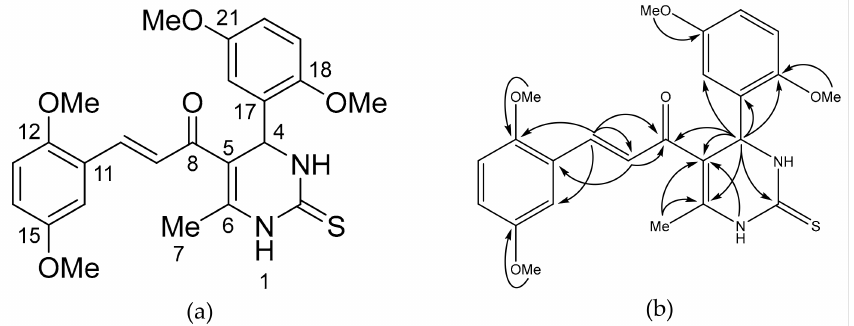
Figure 3. ( a ) Numbering of the structure, and ( b ) selected HMBC correlation for compound 5